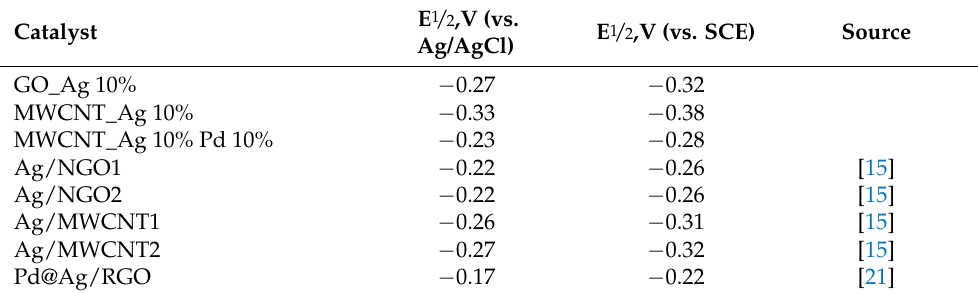
Table 5. Half-wave potential for the catalysts given in this paper and in the